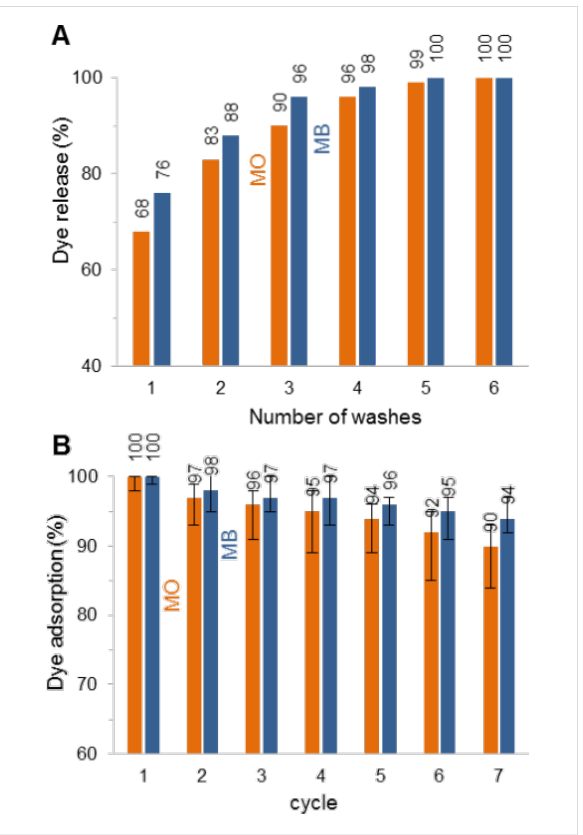
Figure 5: A) Cumulative quantities of dyes released after each wash. MO is desorbed from NP-PEIP05 with sodium hydroxide aqueous solution, MB from NP-PEIP90 with diluted nitric acid. B) The efficiency of the dyes extraction remains high after several adsorption/desorp- tion